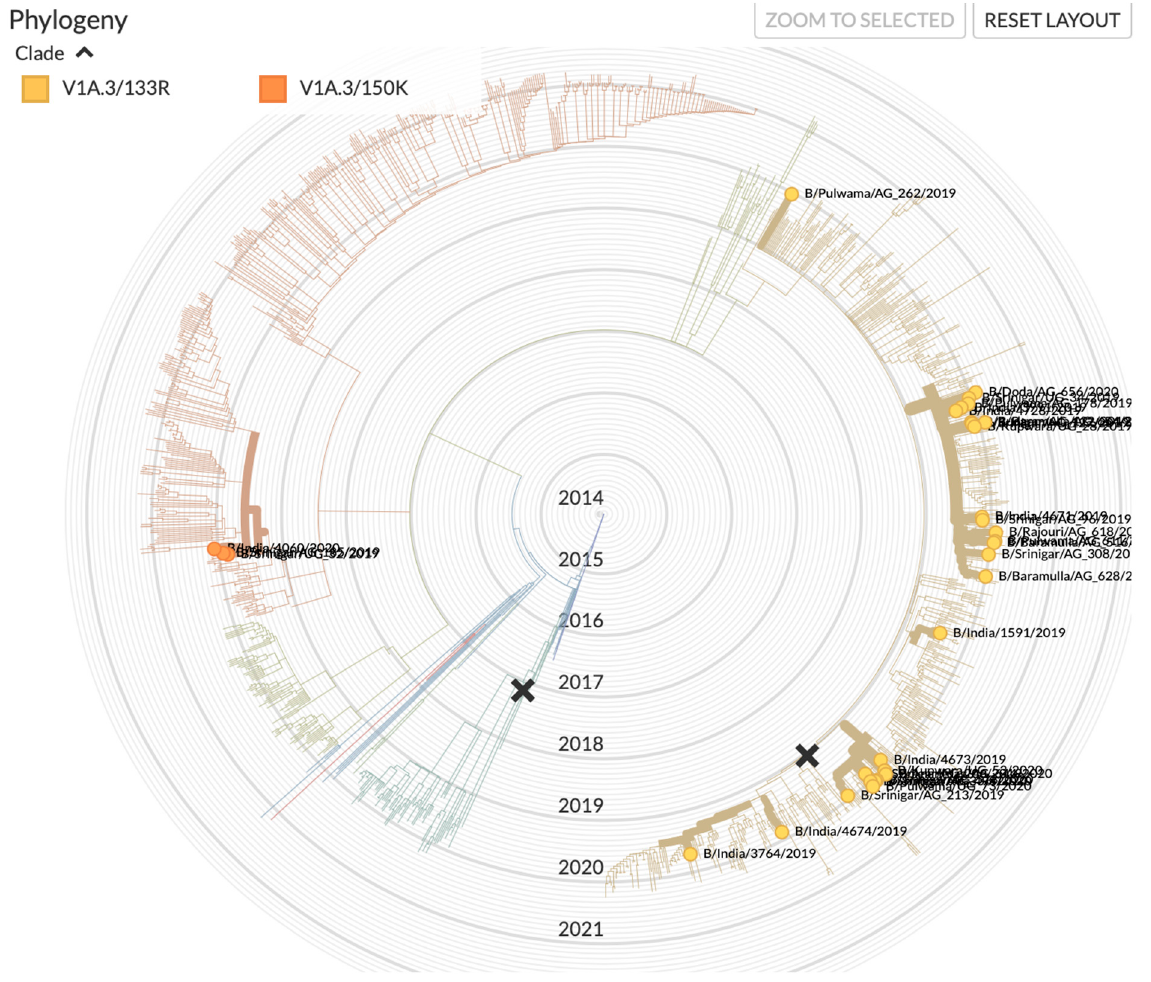
Figure 2. Phylogenetic tree of B/Victoria of samples in relation to the samples from India in the period under study. (source: www.gisaid.org accessed on 18 June 2021).